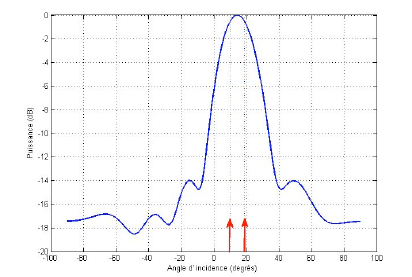
Fig. 5. Direction of arrival of two sources using the optimal beamforming